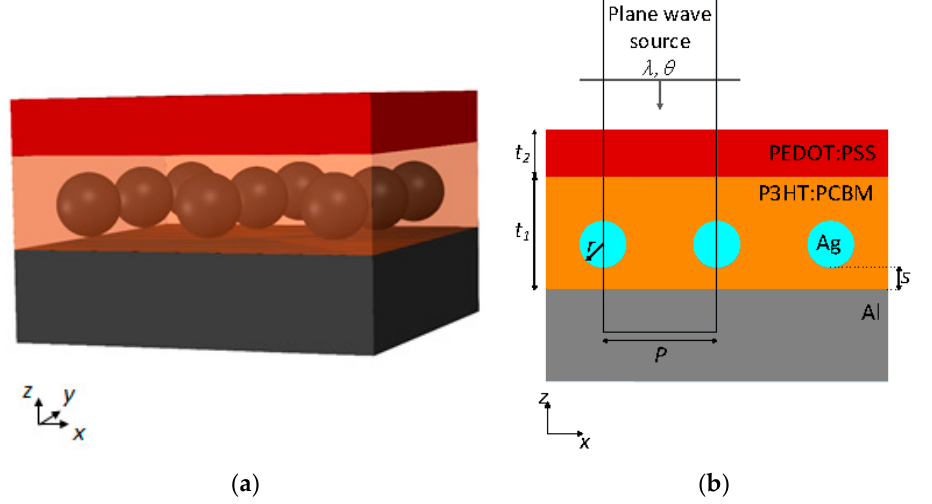
Figure 1. ( a ) 3D view of organic photovoltaic (OPV); ( b ) 2D Schematic of OPV with finite difference time domain (FDTD) solution domain.